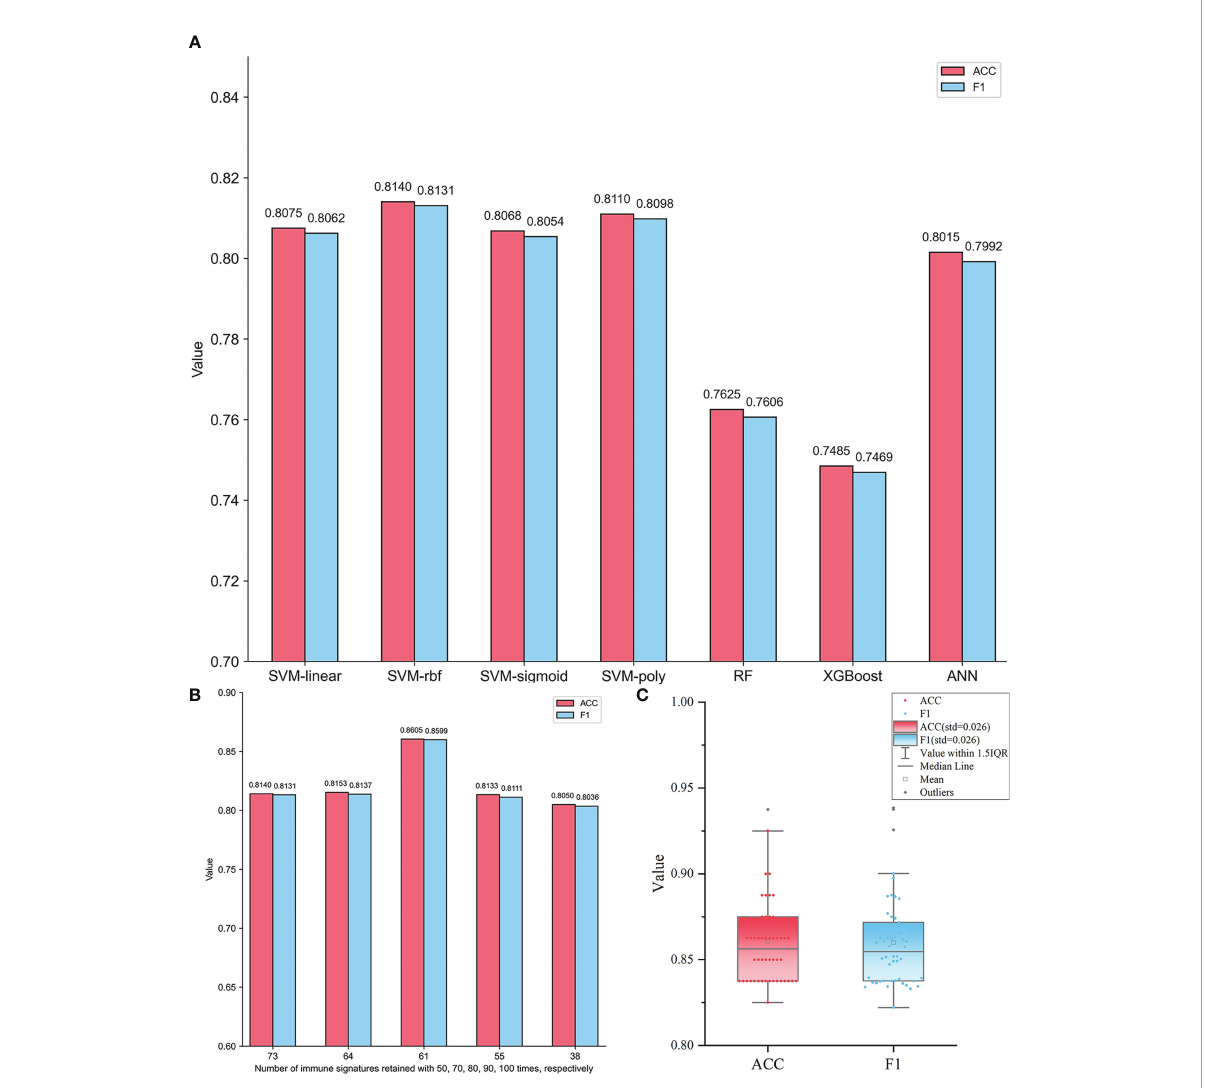
FIGURE 1 (A) Performance comparisons of different ML models based on 73 immune signatures retained at least 50 times in SVM-RFE 100 times. The ACC and the F 1 values of each model are the averages of those for 50 different testing sets generated by randomly dividing each subtype dataset into training and testing sets 50 times. (B) Comparisons of RBF-based SVM models based on fi ve feature subsets containing immune signatures retained at least 50, 70, 80, 90, and 100 times, respectively. The ACC and the F 1 values of each model are the averages of those for 50 different testing sets generated by randomly dividing each subtype dataset into training and testing sets 50 times. (C) The distributions of ACC and F 1 values of 50 different testing sets based on the RBF-based SVM model with 61 optimal immune signatures retained at least 80